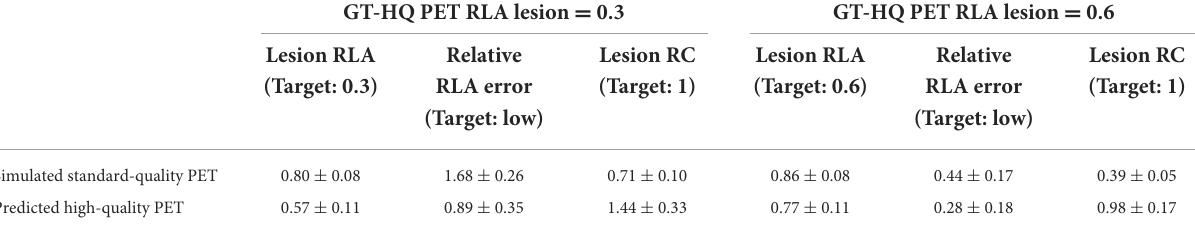
TABLE 3 Mean and standard deviation of the lesion relative lesion activity (RLA), the relative RLA error, and the lesion recovery coefficient (RC) for simulated standard quality, and predicted high quality (HQ) PET images in the test set.